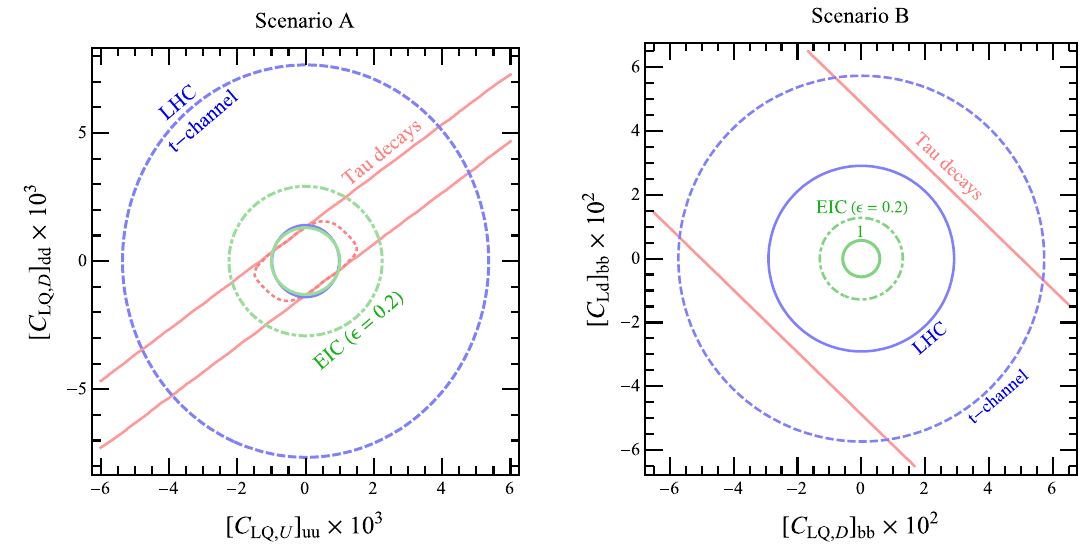
Figure 23 . The 90% C.L. limits in [ C LQ,U ] uu − [ C LQ,D ] dd (scenario A, left) and [ C LQ,D ] bb − [ C Ld ] bb planes (scenario B, right). The pink lines are limits from τ decays, while the pink dotted contour presents the case incorporating τ → eK + K − channel. The blue and green solid lines are bounds from the LHC and EIC ( (cid:15) = 1 with n = 0 ), respectively. The blue dashed line assumes a t - n b b channel exchange of a particle with M = 1 TeV at the LHC, and the green dash-dotted line assumes = 0 . 2 in the EIC (cid:15) n b